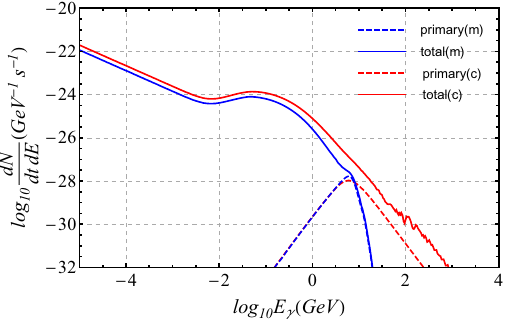
Figure 1. Instantaneous emission rate of photons for PBHs with horizon mass 10 13 g, for the same energy fraction of the monochromatic (denoted by the script “m”, the blue curve) and critical collapse mass functions (denoted by the script “c”, the red